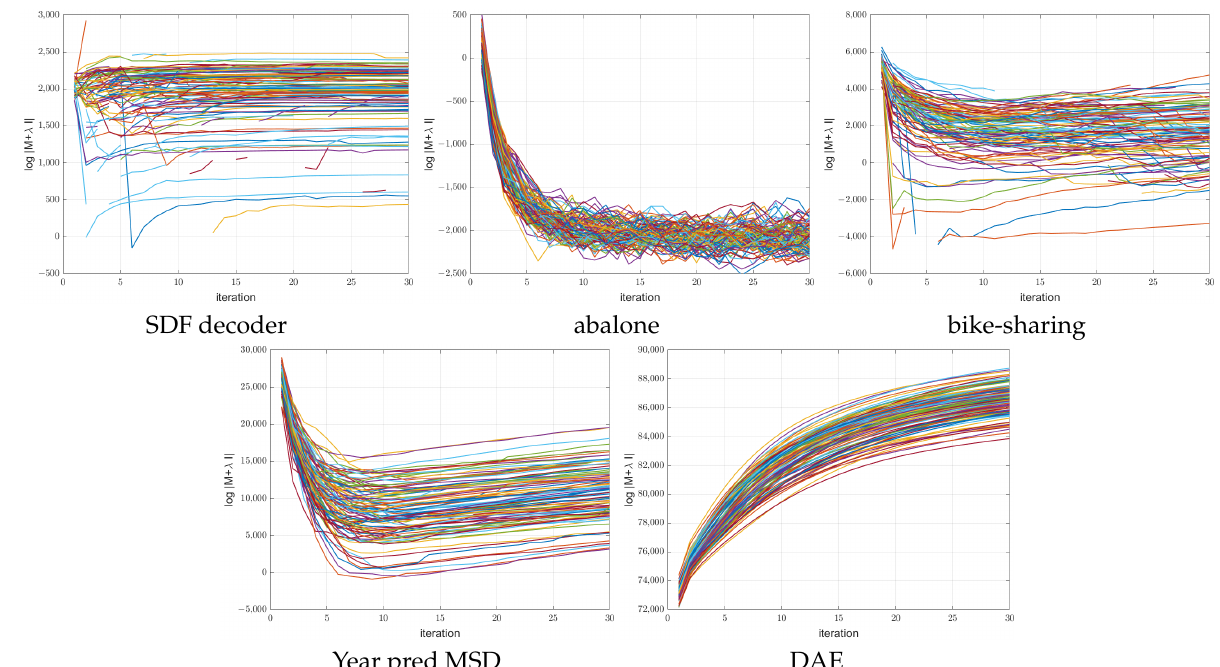
Figure 10. Plot of the ln | M + λ I ( d + 1 ) h | vs iteration number for the 100 ANMIN (Algorithm 1) runs for NN with ReLU activation. The different runs are shown in different colors.